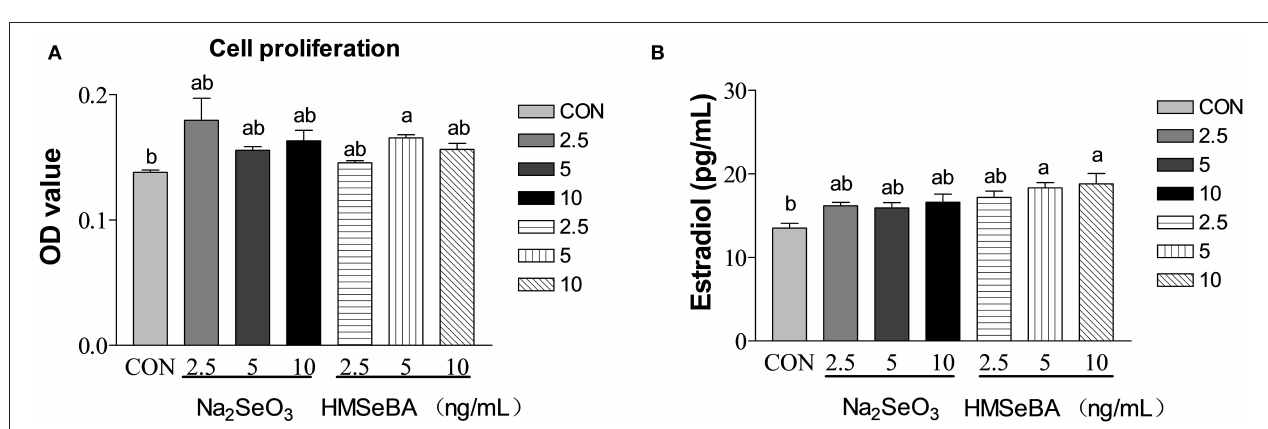
FIGURE 6 | Effects of selenium from different sources and concentrations on the granulosa cells’ proliferation (A) and estradiol (B) secretion in granulosa cells in vitro . Data are expressed as means values and standard error. a,b Mean values with different superscript letters were significantly different ( P < 0.05). CON: basal media, Na 2 SeO 3 2.5, 5 and 10 ng Se/ml, HMSeBA 2.5, 5, and 10 ng